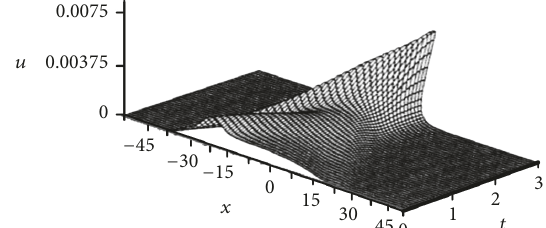
Figure 6: The shape of approximated solution 𝑢 app = 𝑢 3 in the pure fractional case ( 𝛾 = 0.80 ), plotted with respect to different fixed values of time and space at 𝑘 = 2.5 , 𝑑 = 4.0 , 𝜁 = 0.01. The motion is shown to behave irregularly compared to the conventional case and the dynamic tending to a chaotic